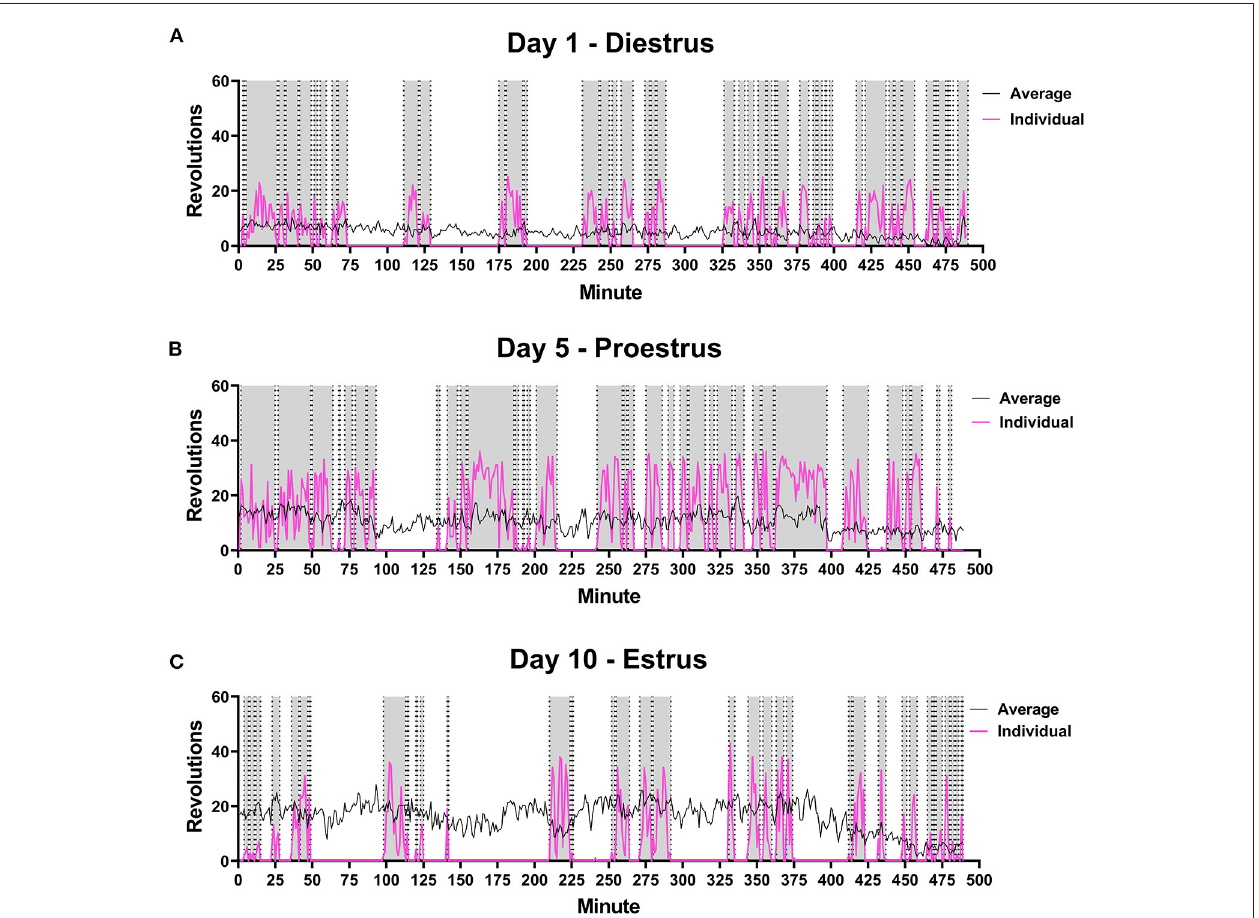
FIGURE 3 | Female Rat Running Pattern. Rats were placed in a cage with voluntary access to a running wheel from 10:00–06:00 (480min) for 10 days. Stage in estrous cycling (Diestrus, Proestrus, Estrus) was monitored upon removal from wheels. An example is shown of the running pattern of one female in the study on Day 1 (A) , Day 5 (B) and Day 10 (C) of wheel access. Distance run was compared to estrous stage, but no correlations were observed. Pink line is the number of revolutions run by the individual rat. The gray portions highlight running intervals. Black line indicates average distance run by all female rats on each perspective day ( n = 28).